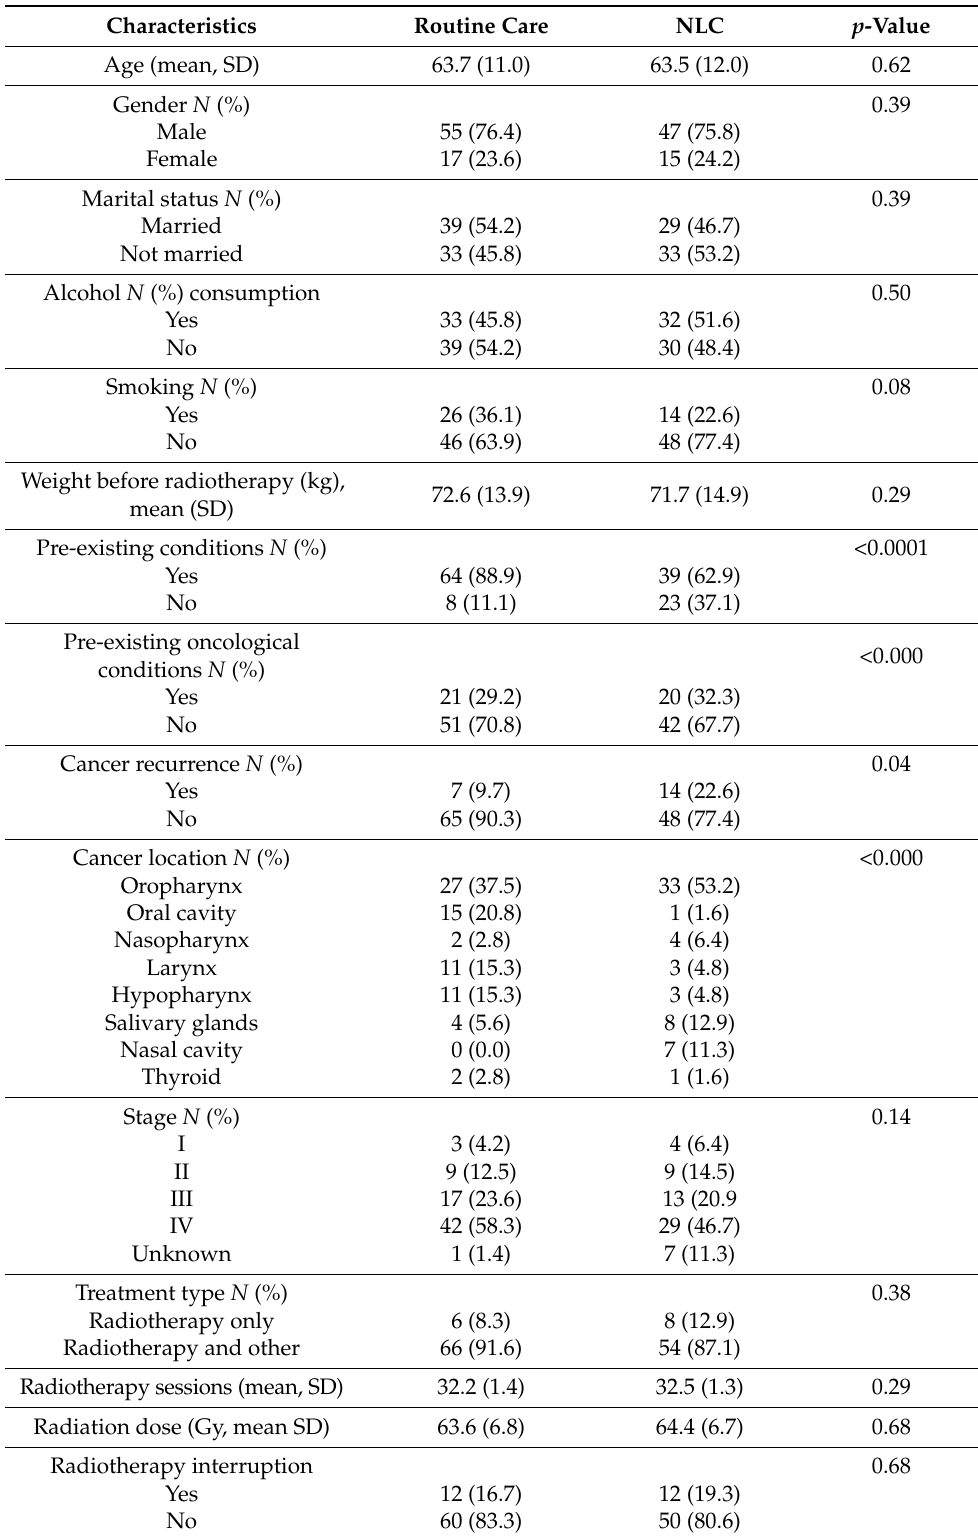
Table 1. Demographic and clinical characteristics of patients by treatment